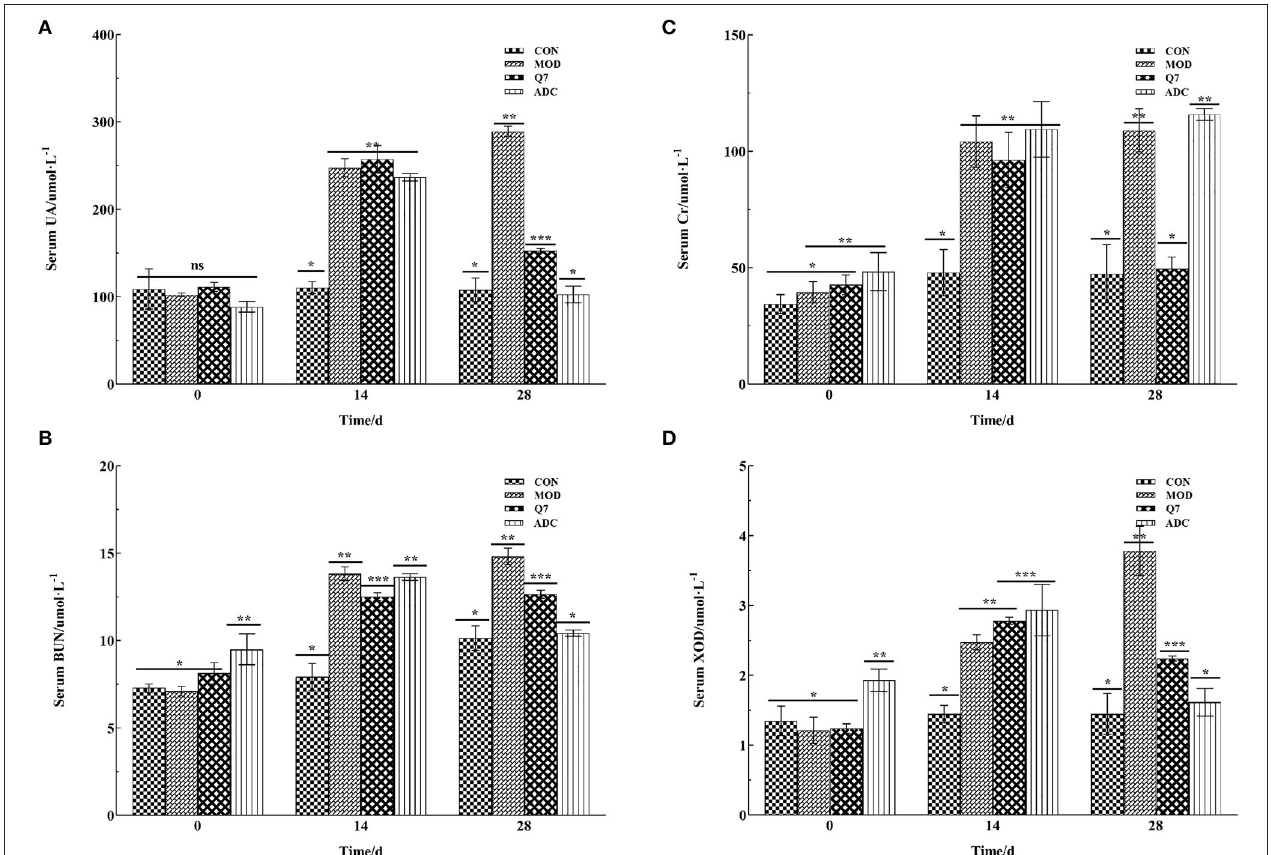
FIGURE 4 | Effects of L. plantarum Q7 on serum indexes in mice at different time points. (A) UA; (B) BUN; (C) Cr; (D) XOD.